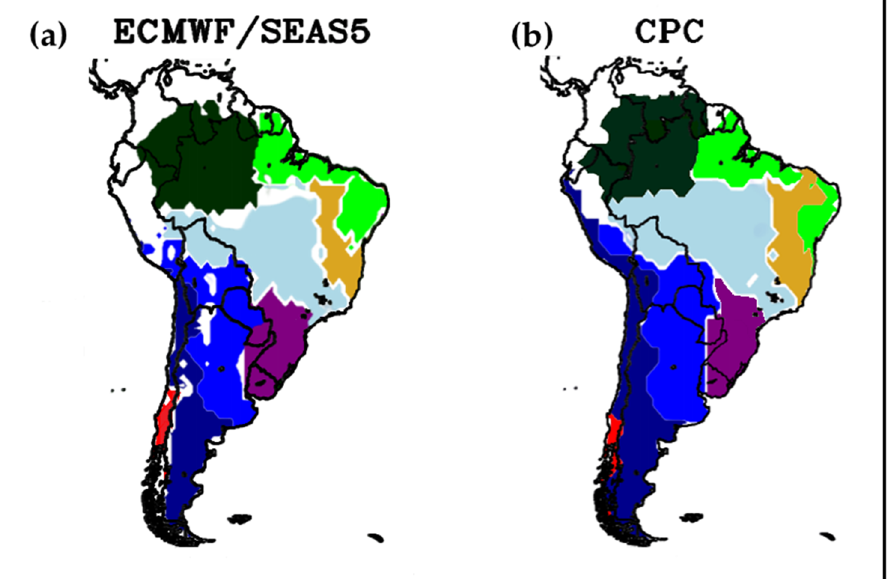
Figure 5. Clusters provided by the K-means method (represented by different colors) applied to ( a , b ) monthly precipitation climatology (1993 to 2016) in South America.